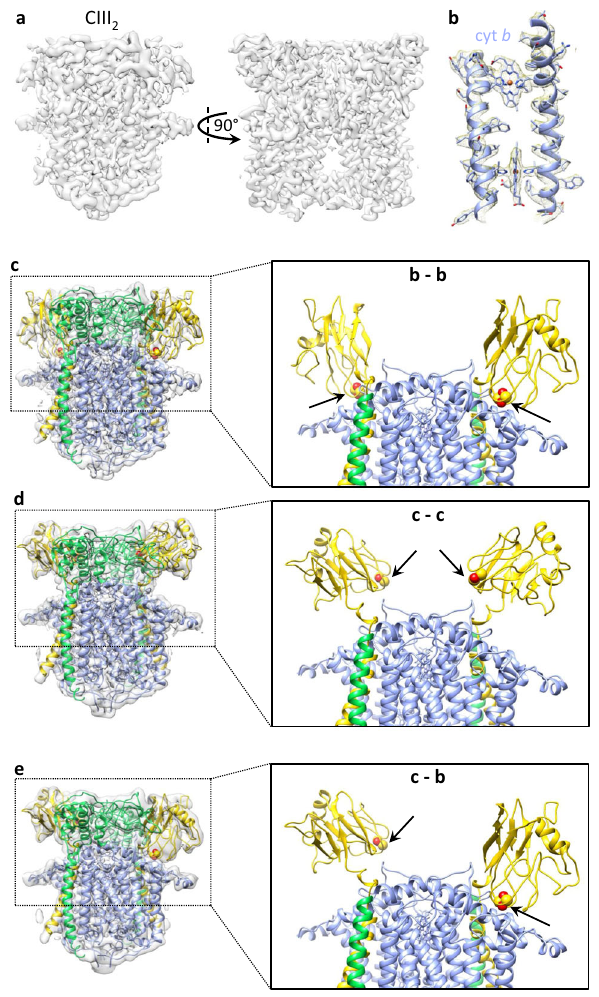
Fig. 3 Structures of native CIII 2 conformers. a Cryo-EM map CIII 2 b-b (EMD-22226) with both FeS proteins in b position. b Representative region of CIII 2 b-b demonstrating map quality and model fi tting. TMH2 and TMH4 of cyt b with hemes b L and b H are shown. c – e Maps and models showing different conformations of the FeS proteins. The left panels show the CIII 2 structure fi tted into the different maps with the subunit colorings (cyt b in periwinkle, cyt c 1 in green, and the FeS protein in yellow) as in Fig. 2. The right panels show the top half of the models with the membrane-external domain of cyt c 1 omitted to better visualize the b-b, c-c, and c-b positions of FeS-EDs. The [2Fe-2S] clusters are shown as yellow – red spheres and indicated by arrows. c Structure of native CIII 2 with both FeS-EDs in b position (map CIII 2 b-b, EMD-22226; PDB: 6XKV). d Structure of native CIII 2 with both FeS-EDs in c position (map CIII 2 c-c, EMD-22224; PDB: 6XKT). e Structure of native CIII 2 with one FeS-ED in c and one in b position (map CIII 2 b-c, EMD-22225; PDB: